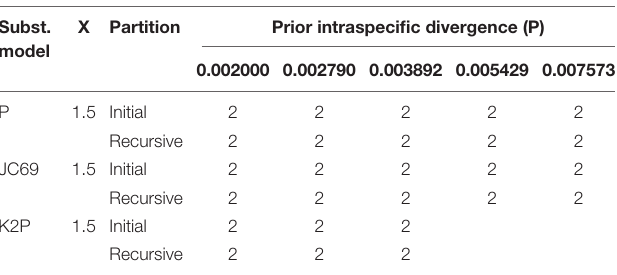
TABLE 3 | The number of putative species recognized by Automatic Barcode Gap Discovery (ABGD) analyses among 51 nrDNA sequences using three distance metrics.